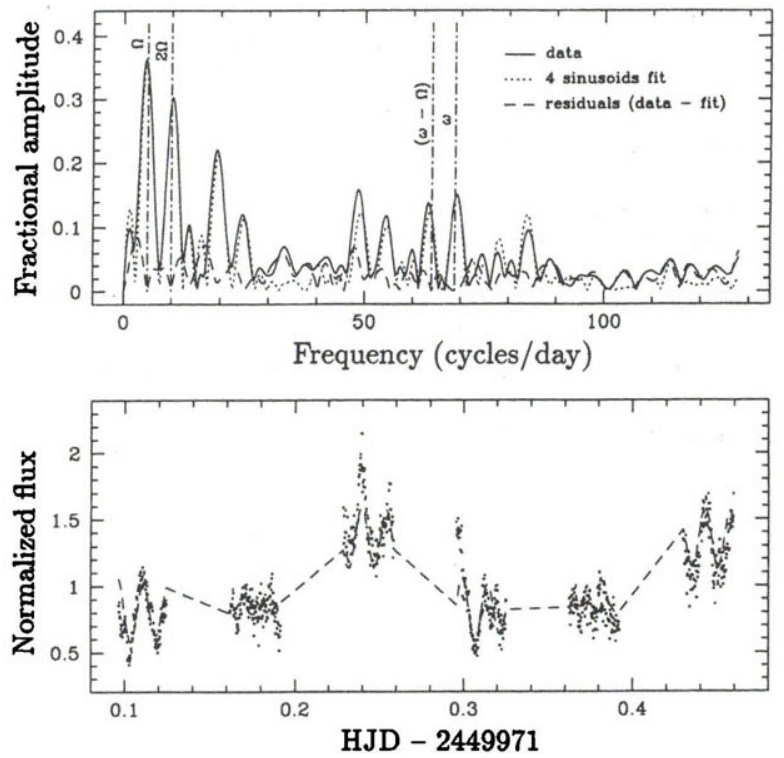
Fig. 3. Light curve and relative DFT of the UV emission line fluxes (NV + Si IV + CIV +